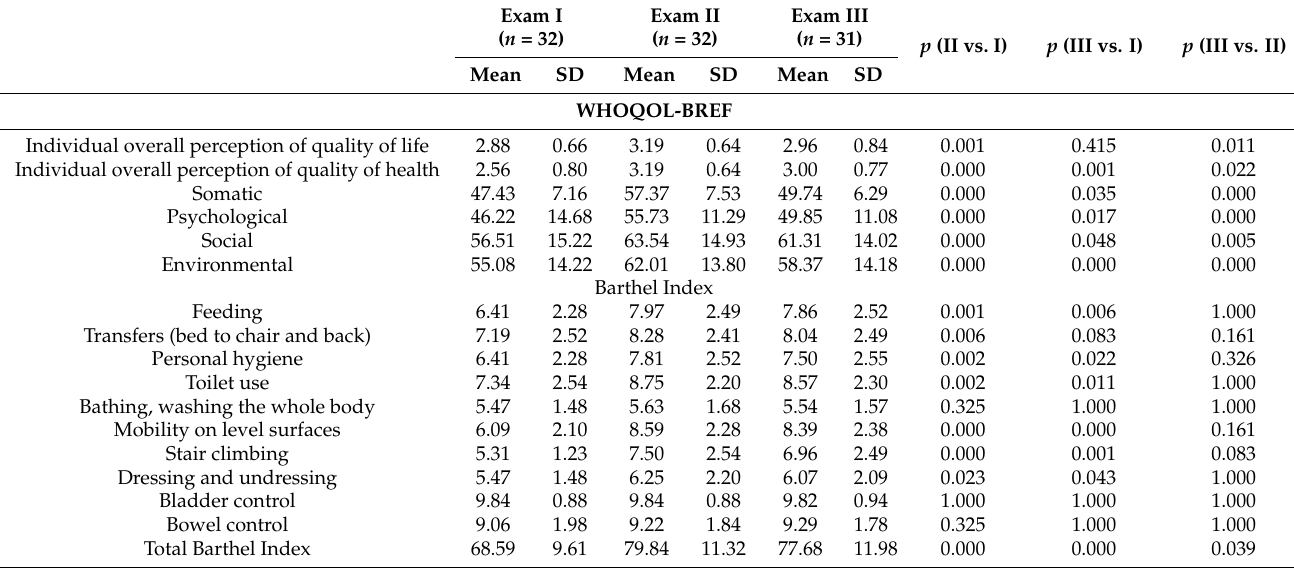
Table 2. WHOQOL-BREF and Barthel scores in Exams I, II and III for the whole group. Exam I ( n = 32)